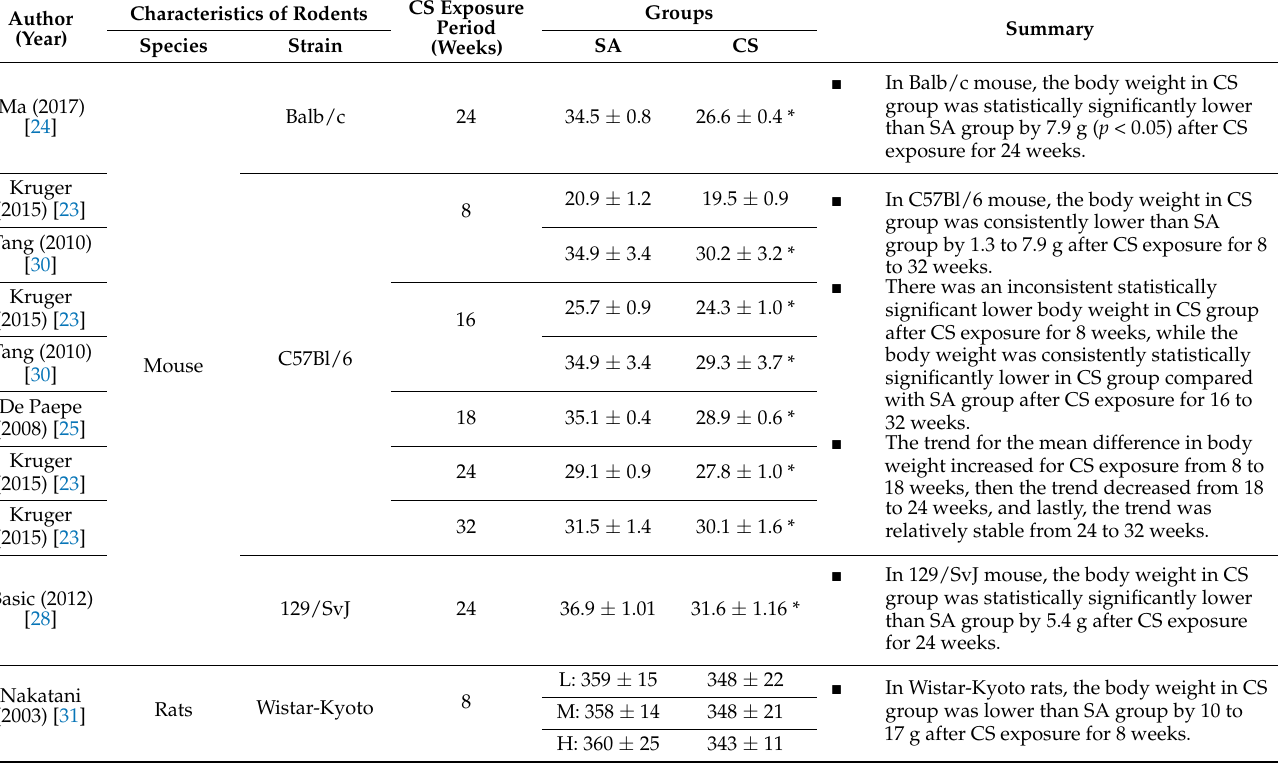
Table 6. Summary of the body weight at different time points during CS